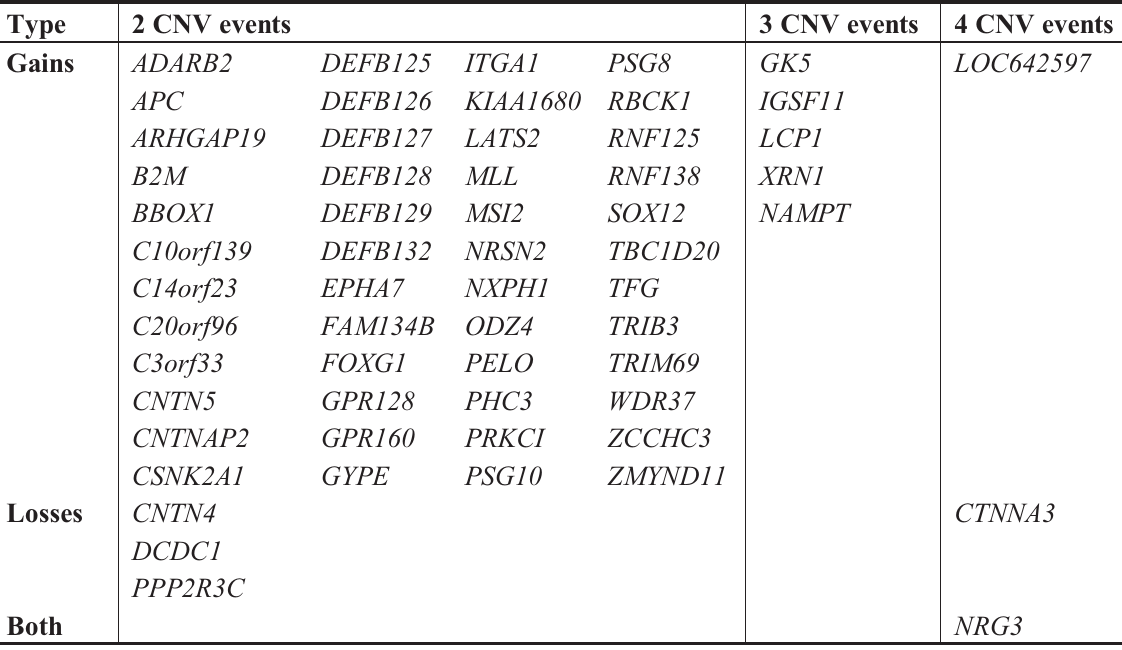
Table 3. Genes associated with unique CNVs (compared to controls) identified across multiple patients. Number of CNV events in which gene (s) have been identified and if they were a CN gain or